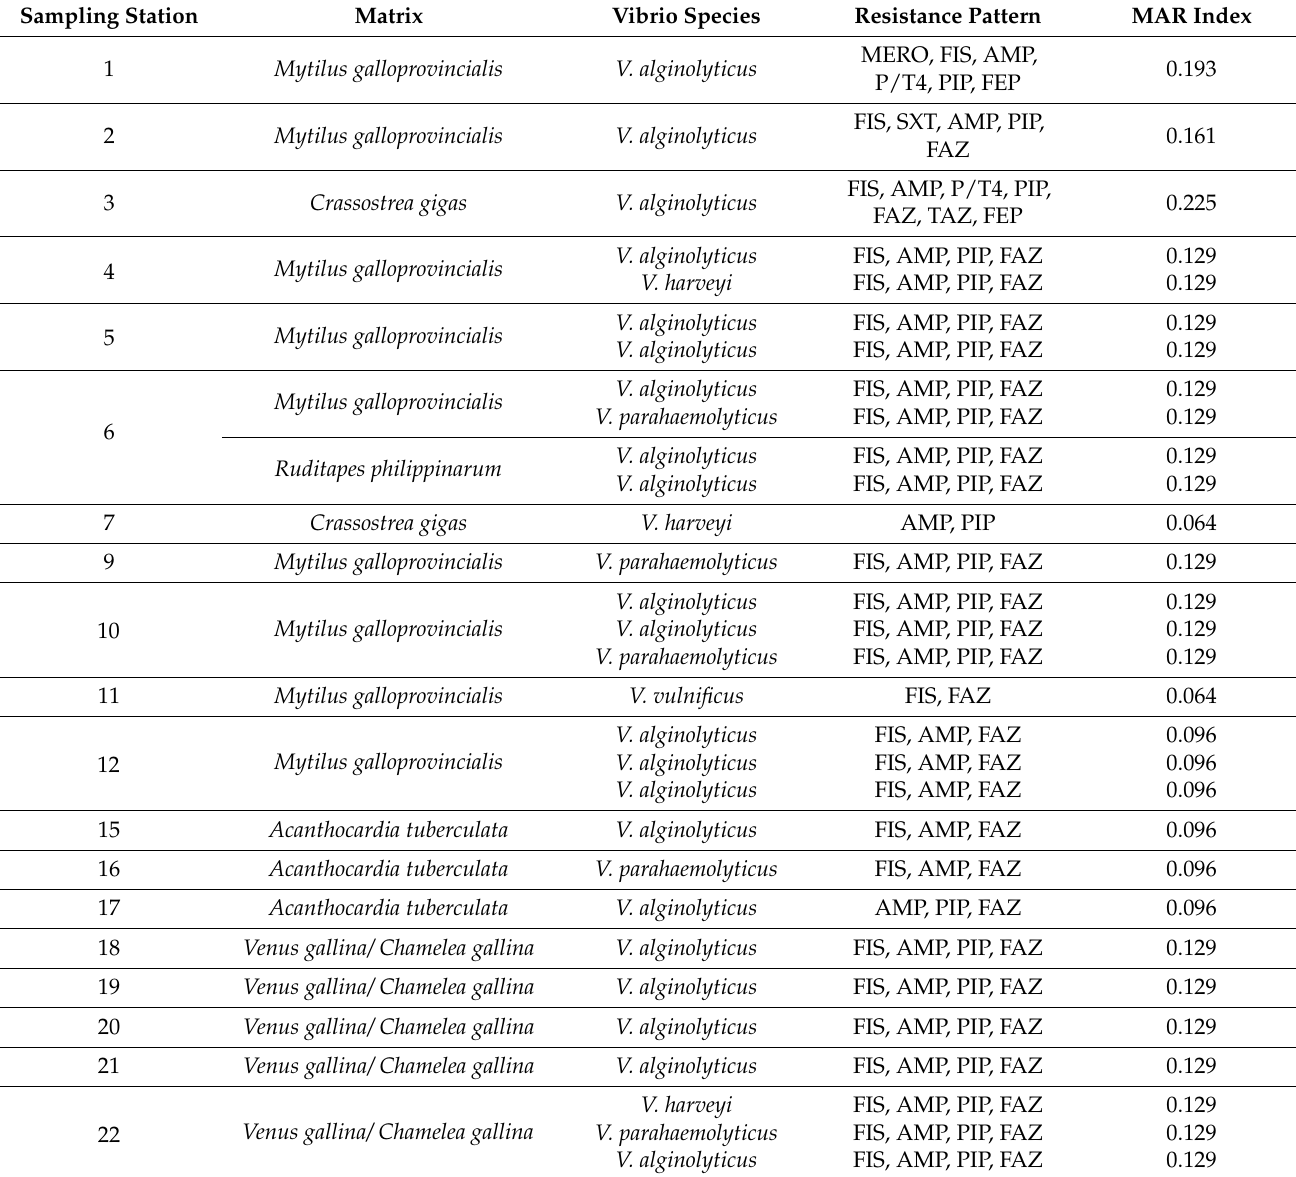
Table 2. The highest values of multiple antibiotic resistance (MAR) index of Vibrio